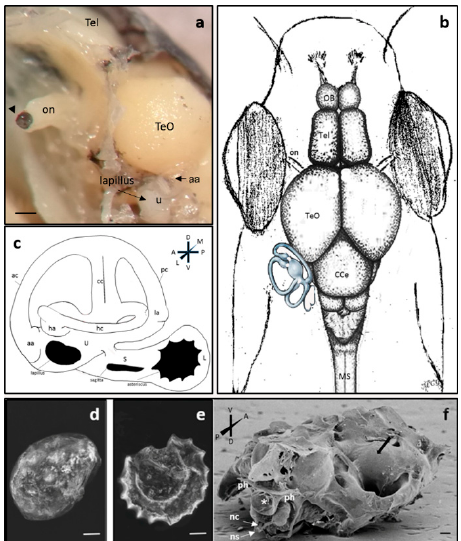
Figure 1. ( a ) Stereomicrograph: Cranial cavity dissection in adult zebrafish, lateral view: the bone skull has been removed in order to highlight the brain and the topographical relationships with the inner ear; some bony labyrinth was dissected away to improve visualization of membranous labyrinth: Tel—Telencephalon; TeO—Optic tectum; on—optic nerve with optic papilla (arrowhead)